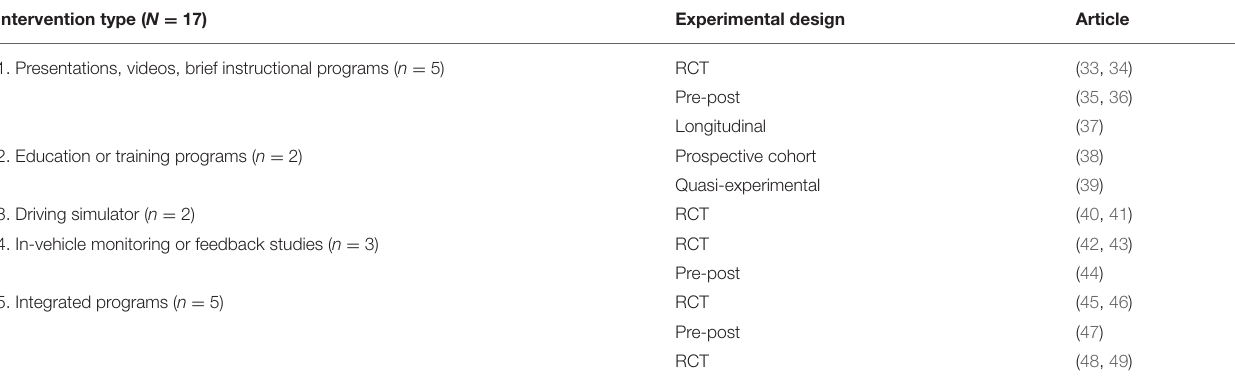
TABLE 2 | Summary of intervention types separated by experimental